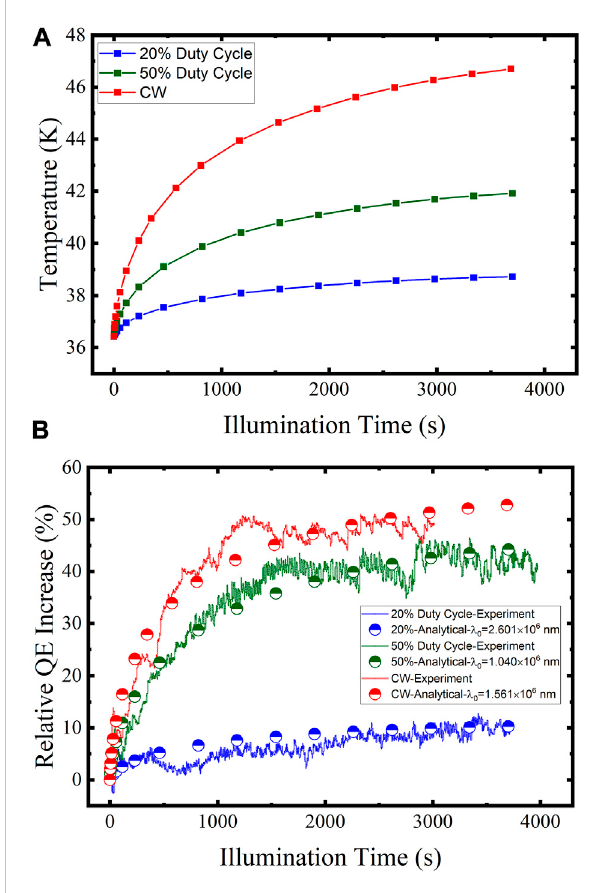
FIGURE 5 Simulation of QE changes in DC-SRF photoinjector during macro-pulse operation at different duty cycles. (A) Simulated temperature rise during laser illumination. (B) Comparison between the experimental data and the calculated relative QE increase using Eq. 9 with different λ 0